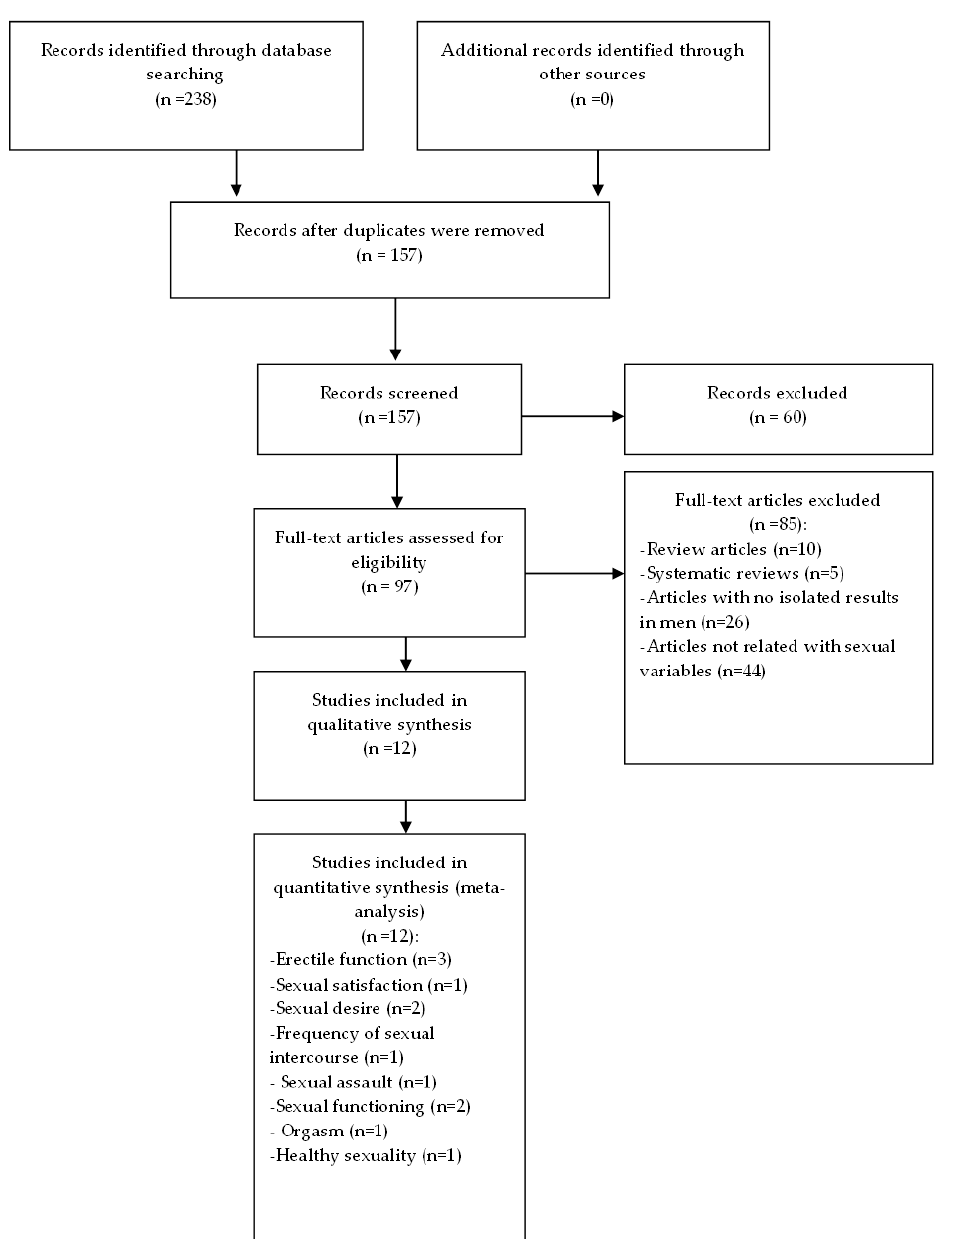
Figure 1. PRISMA flow in the selection of articles.